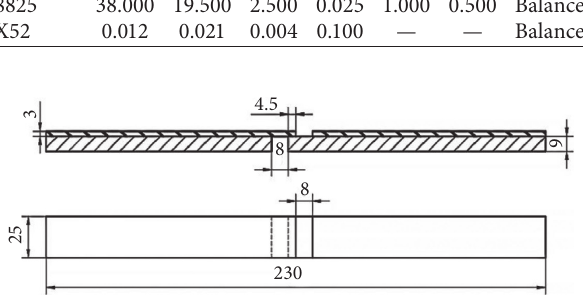
Figure 1: Schematic diagram of shear specimens (in